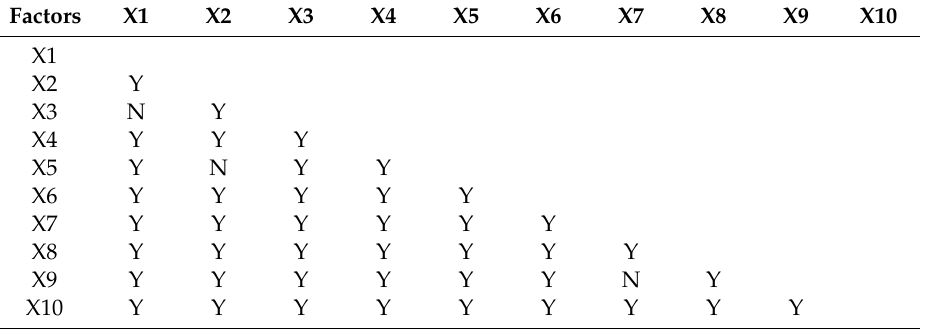
Table 5. Statistical significance of detection factors (95% confidence level).